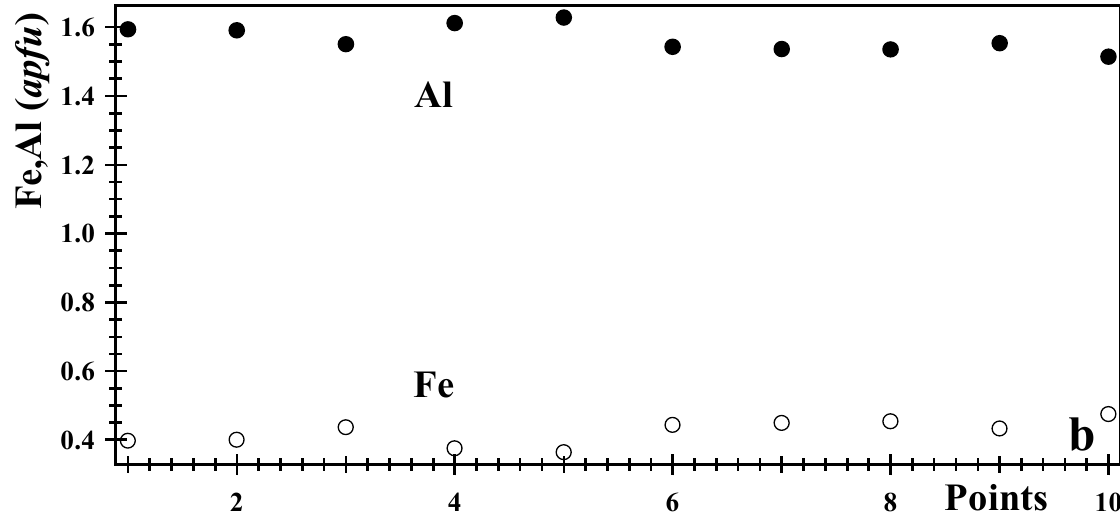
Figure 10. ( a ) Line scans along the line A to B in Figure 9c showing the inverse relation between Fe 3+ and Al 3+ cations, homogeneous Ca, and variable Ti distributions. The scans indicate Fe-poor and Fe-rich phases. ( b ) Quantitative chemical analyses from points 1 to 10 showing the inverse relation between Al and Fe atoms in the Y site (Figure 9c; Table 1). Note that Fe + Al = 2 apfu . The line scan units are arbitrary.